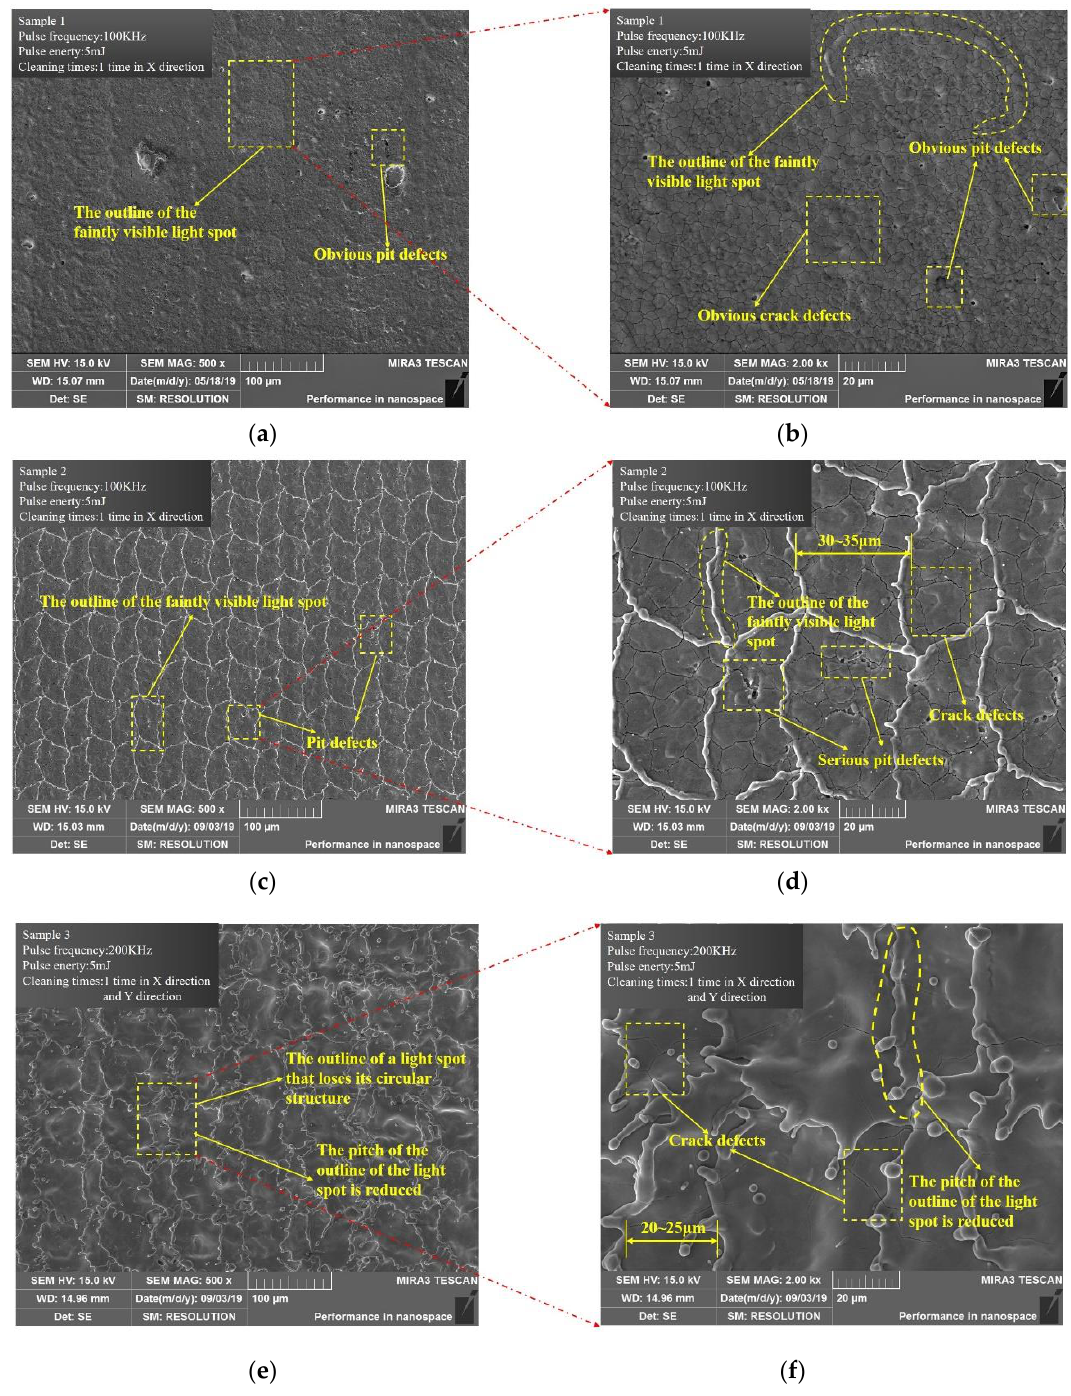
Figure 5. Electron microscope surface morphology of the sample after cleaning: ( a ) 500× magnification for sample 1, ( b ) 2000× magnification for sample 1, ( c ) 500× magnification for sample 2, ( d ) 2000× magnification for sample 2, ( e ) 500× magnification for sample 3, ( f ) 2000× magnification for sample 3.